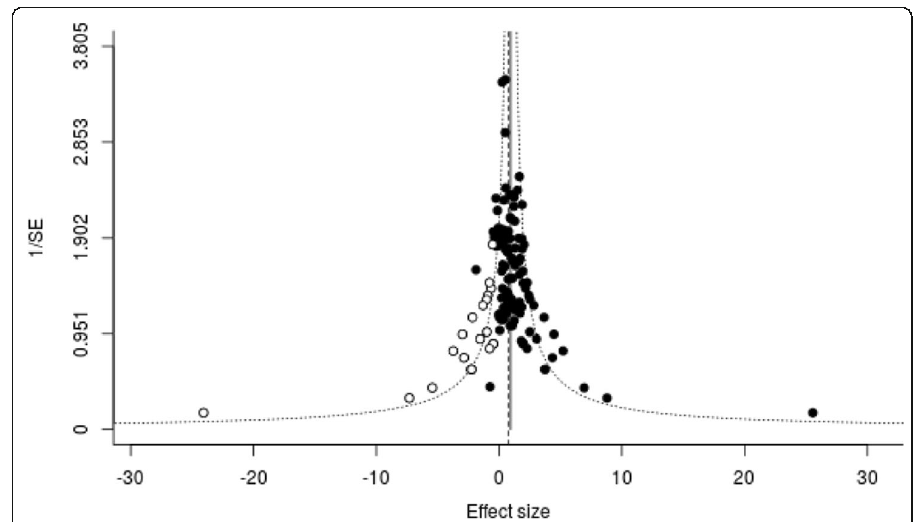
Fig. 2 Funnel plot and Trim and Fill analysis of neurobehavioural outcome. Open circles are missing studies according to Trim and Fill-analysis. Estimate of efficacy with missing studies included: 0.76 SMD [95% CI 0.59 to 0.93]. Efficacy without missing studies: 0.93 SMD [95% CI 0.79 to 1.08]. Standardized mean difference = SMD. Standard error = SE. Confidence interval =